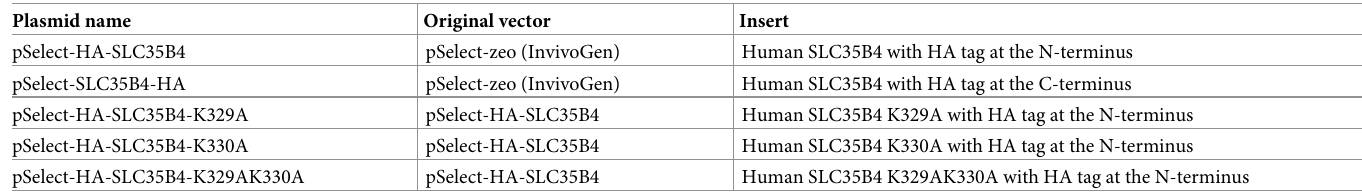
Table 2. List of expression plasmids constructed and used in this